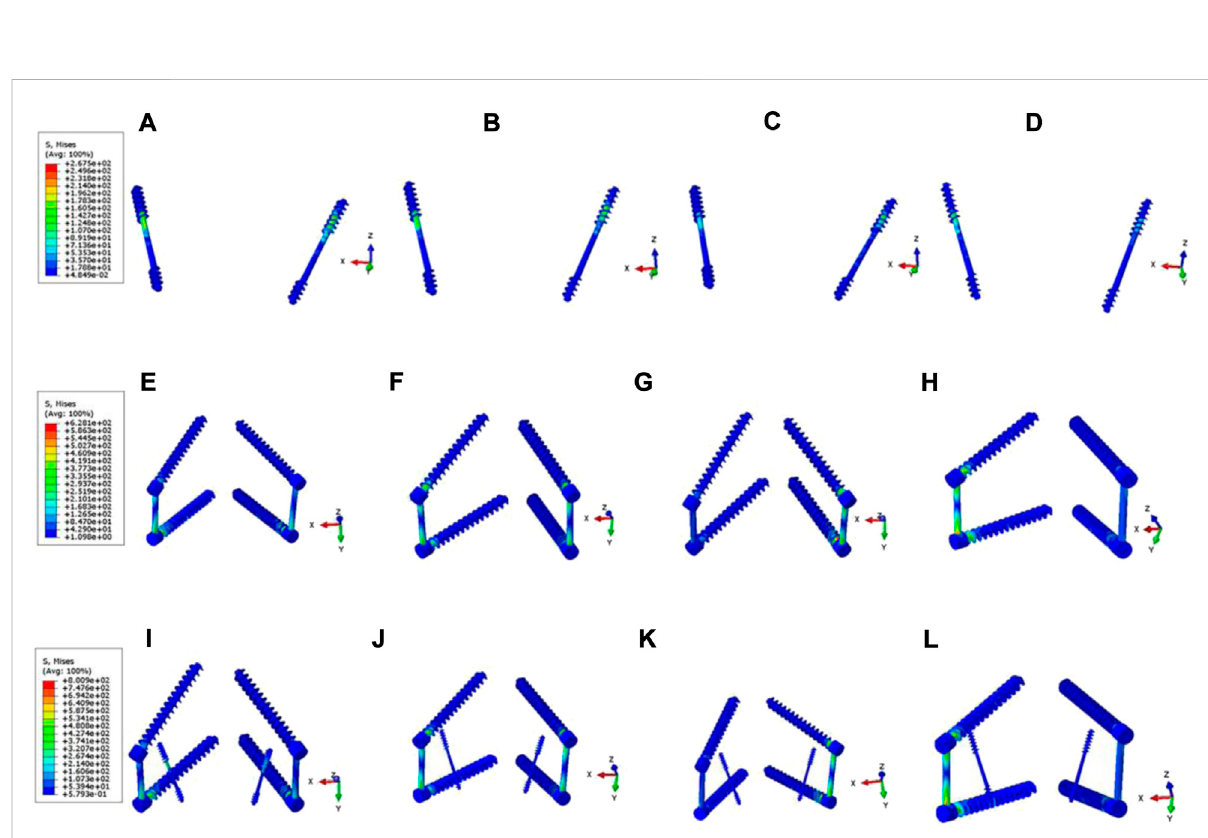
FIGURE 10 Stress nephograms of internal fi xation system in Model C, D, and E under six motion states. (A – D) The stress distribution of Model C ’ s internal fi xation system under fl exion, extension, LAR, and LLB, respectively. (E – H) The stress distribution of Model D ’ s internal fi xation system under fl exion, extension, LAR, RAR, LLB, and RLB, respectively. (I – L) The stress distribution of Model E ’ s internal fi xation system under fl exion, extension, LAR, RAR, LLB, and RLB,